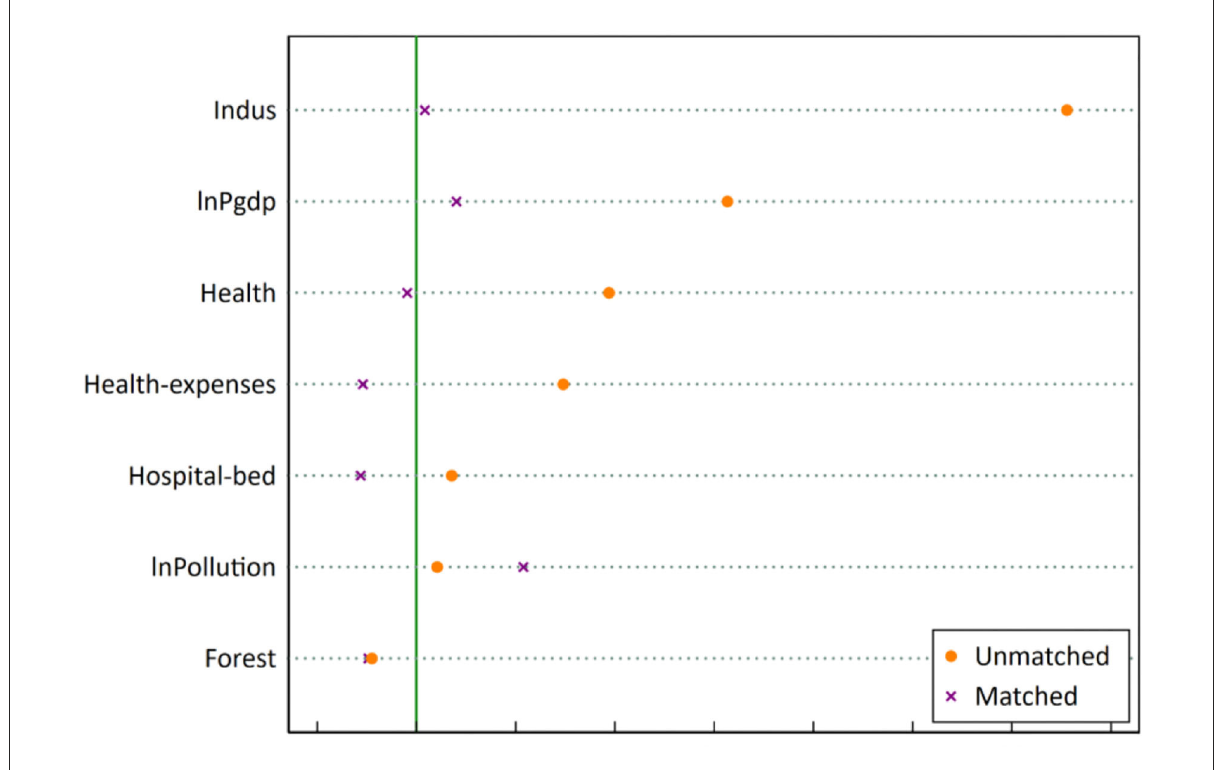
FIGURE4 PSM balance test results.